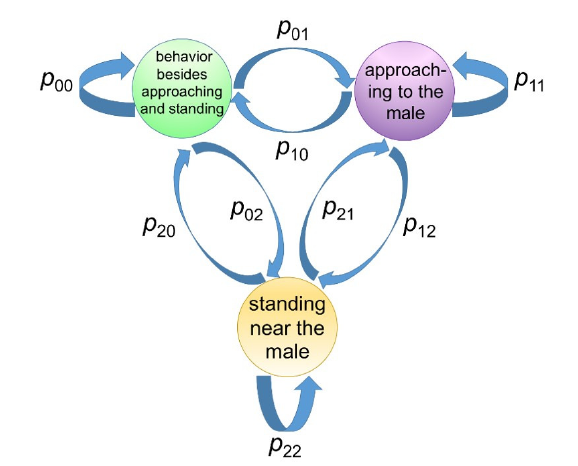
Figure 3. Three-state HMM. Shiba goats show three states, behavior besides approaching and standing, approaching the male, and standing near the male. There is a timing when the state remains the same, and there is a timing when the state transitions to another